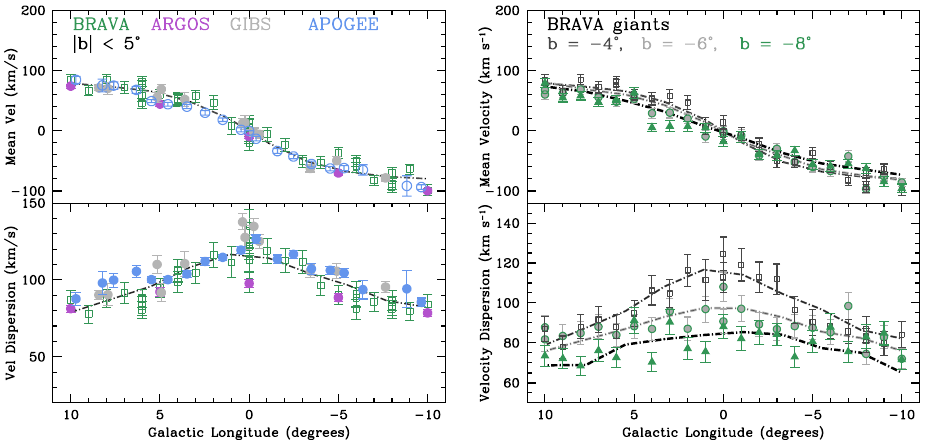
Figure 5. ( Top ) The mean velocity profiles for the stars within | b | < 5 ◦ in the ARGOS (magenta), APOGEE (light blue), BRAVA (green) and GIBS (grey) surveys as a function of Galactic longitude. The lines represent the model by Shen et al. (2010) with a pure bar and no classical component. ( Bottom ) The velocity dispersion of the same surveys as a function of Galactic longitude. The surveys all agree well, and are consistent with the bulge being in pure cylindrical rotation. There are no obvious signs of cold substructure, indicating the lack of recent